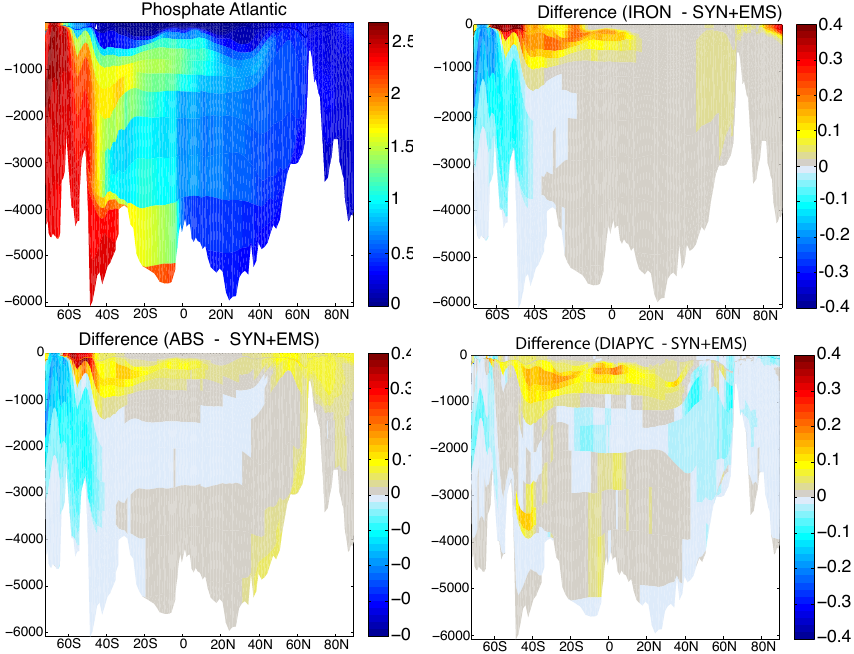
Fig. 20. Annual mean phosphate concentration along a meridional section in the western Atlantic (µmoll − 1 ) for 2007 for SYN+EMS as a reference and differences from this for IRON, ABS and DIAPYC sensitivity experiments.